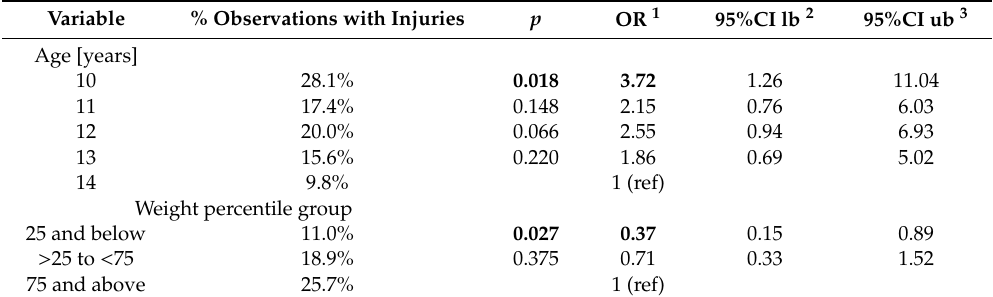
Table 3. Results of the multiple general estimating equation analysis of factors associated with traumatic injuries based on n = 474 observations.